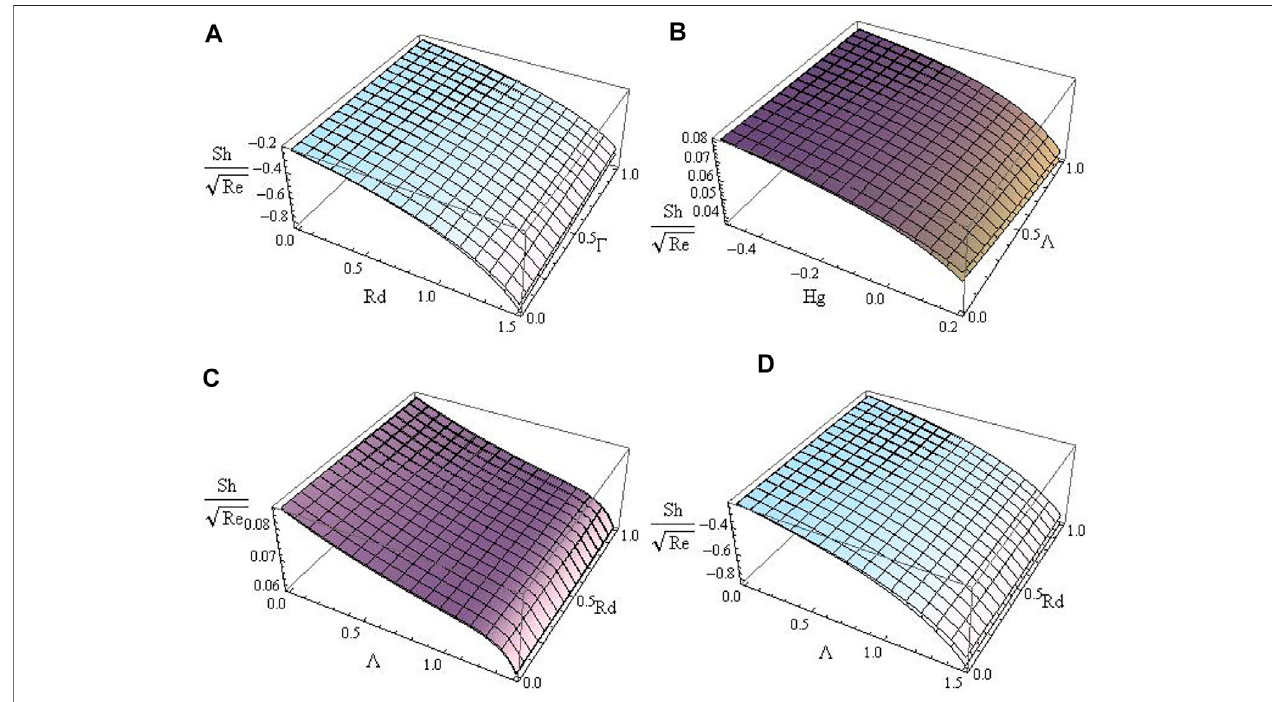
FIGURE8| The variationsof “ Sh ” forvarious combinations ofRd, Γ , Λ , and Hgwith (A) lowerplate ( Λ (cid:1) 0.2) and upper plate( Λ (cid:1) 0.0), (B) lowerplate (Q (cid:1) 0.3) and upperplate(Q (cid:1) 0.0), (C) lowerplate(Q (cid:1) 0.0&Bi (cid:1) 0.5)andupperplate(Q (cid:1) 0.3&Bi (cid:1) 0.5),and (D) lowerplate(Q (cid:1) 0.0&Bi (cid:1)− 0.5)andupperplate(Q (cid:1) 0.3Bi (cid:1)− 0.5).